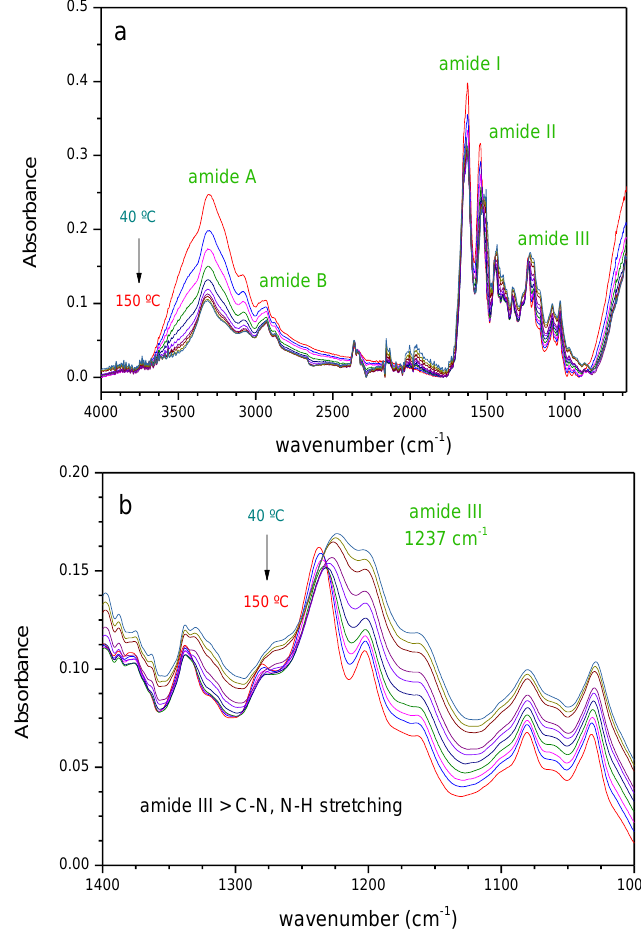
Figure 2. ( a ) ATR-FTIR spectra of Cr(III)-free leather waste as a function of the temperature; and ( b ) zoomed-in view of the amide III zone of the FTIR spectra of Cr(III)-free leather waste as a function of the temperature.